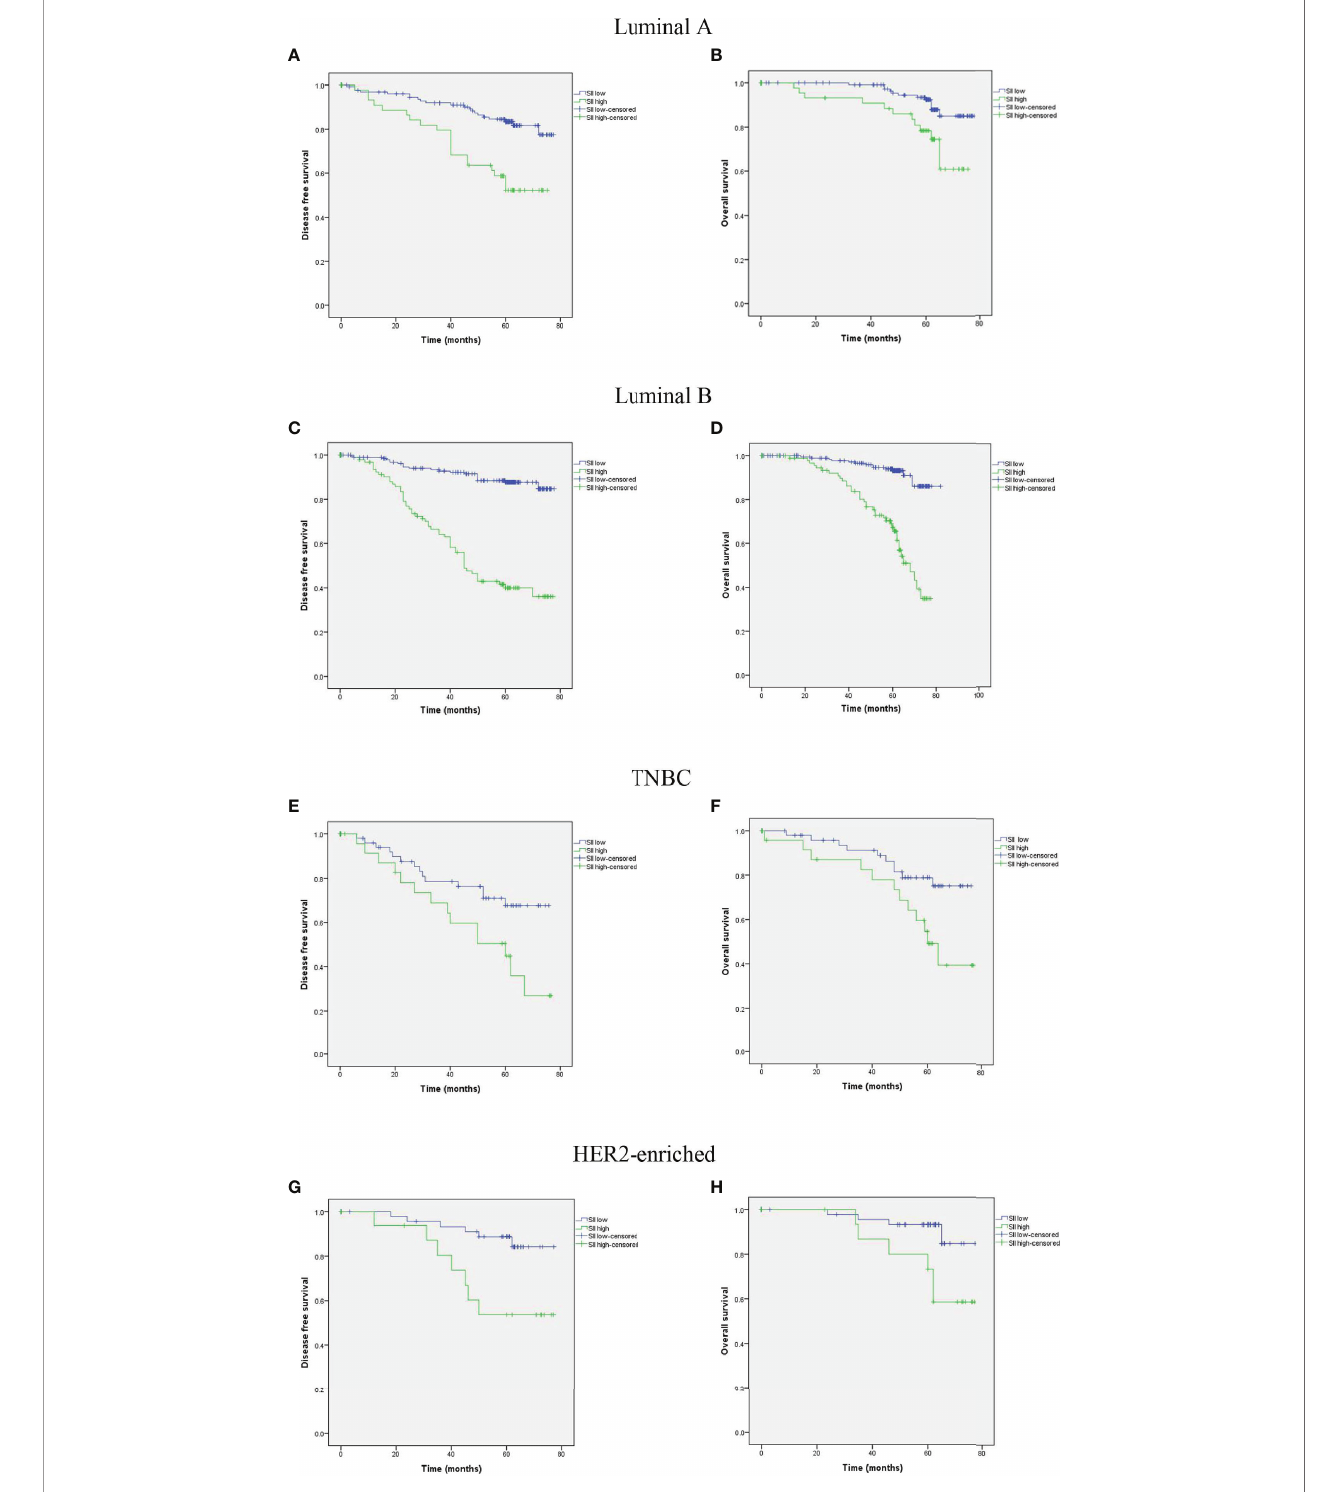
FIGURE 4 | Kaplan-MeierKaplan-Meier survival analyses of DFS and OS according to SII among patients in Luminal A (A, B) , Luminal B (C, D) , TNBC (E, F) , and HER2-enriched (G, H)